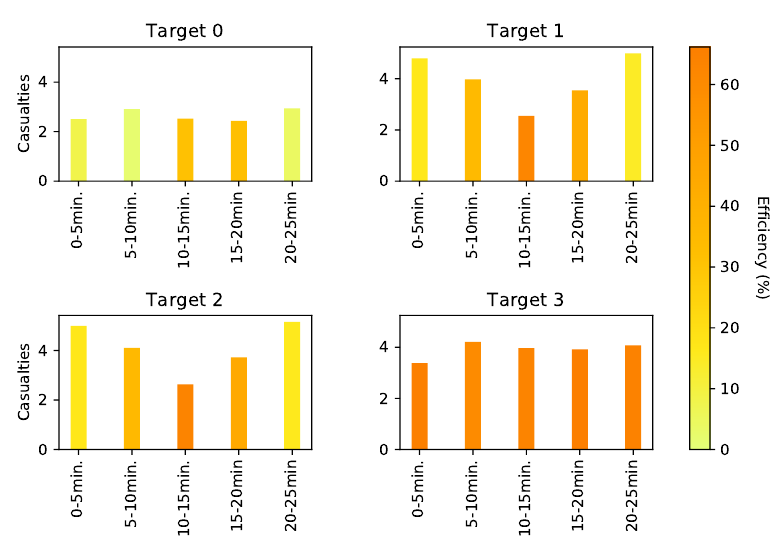
Figure 9. The number of casualties per attacking strategy against the optimal defender’s